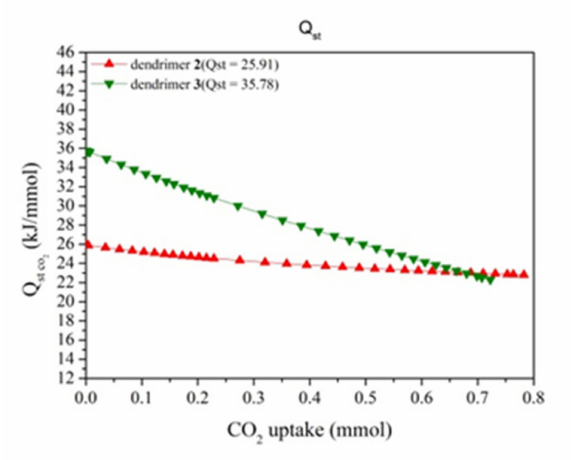
Figure 7. The isosteric heat ( Q st ) of CO 2 sorption of dendrimers 2 and 3